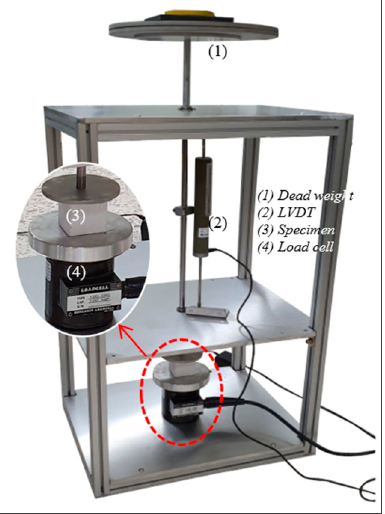
Figure 4. Uniaxial compression creep test apparatus for EPS.